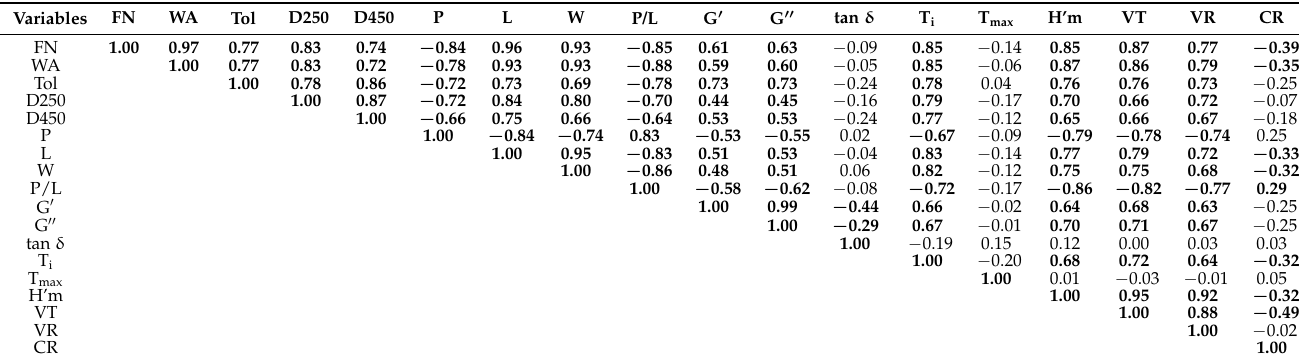
Table 5. Pearson’s correlation